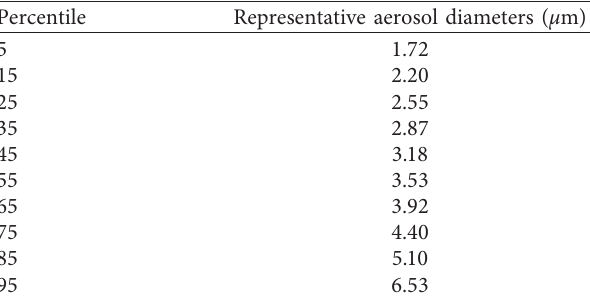
Table 3: Representative CsOH aerosol sizes for the calculation in Modified ART Mod